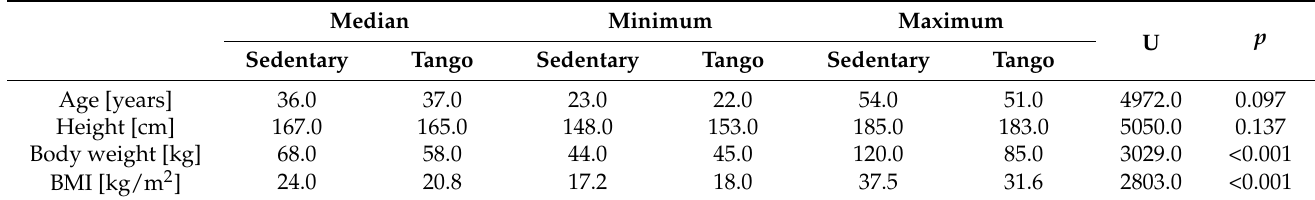
Table 1. Age and anthropometric parameters of